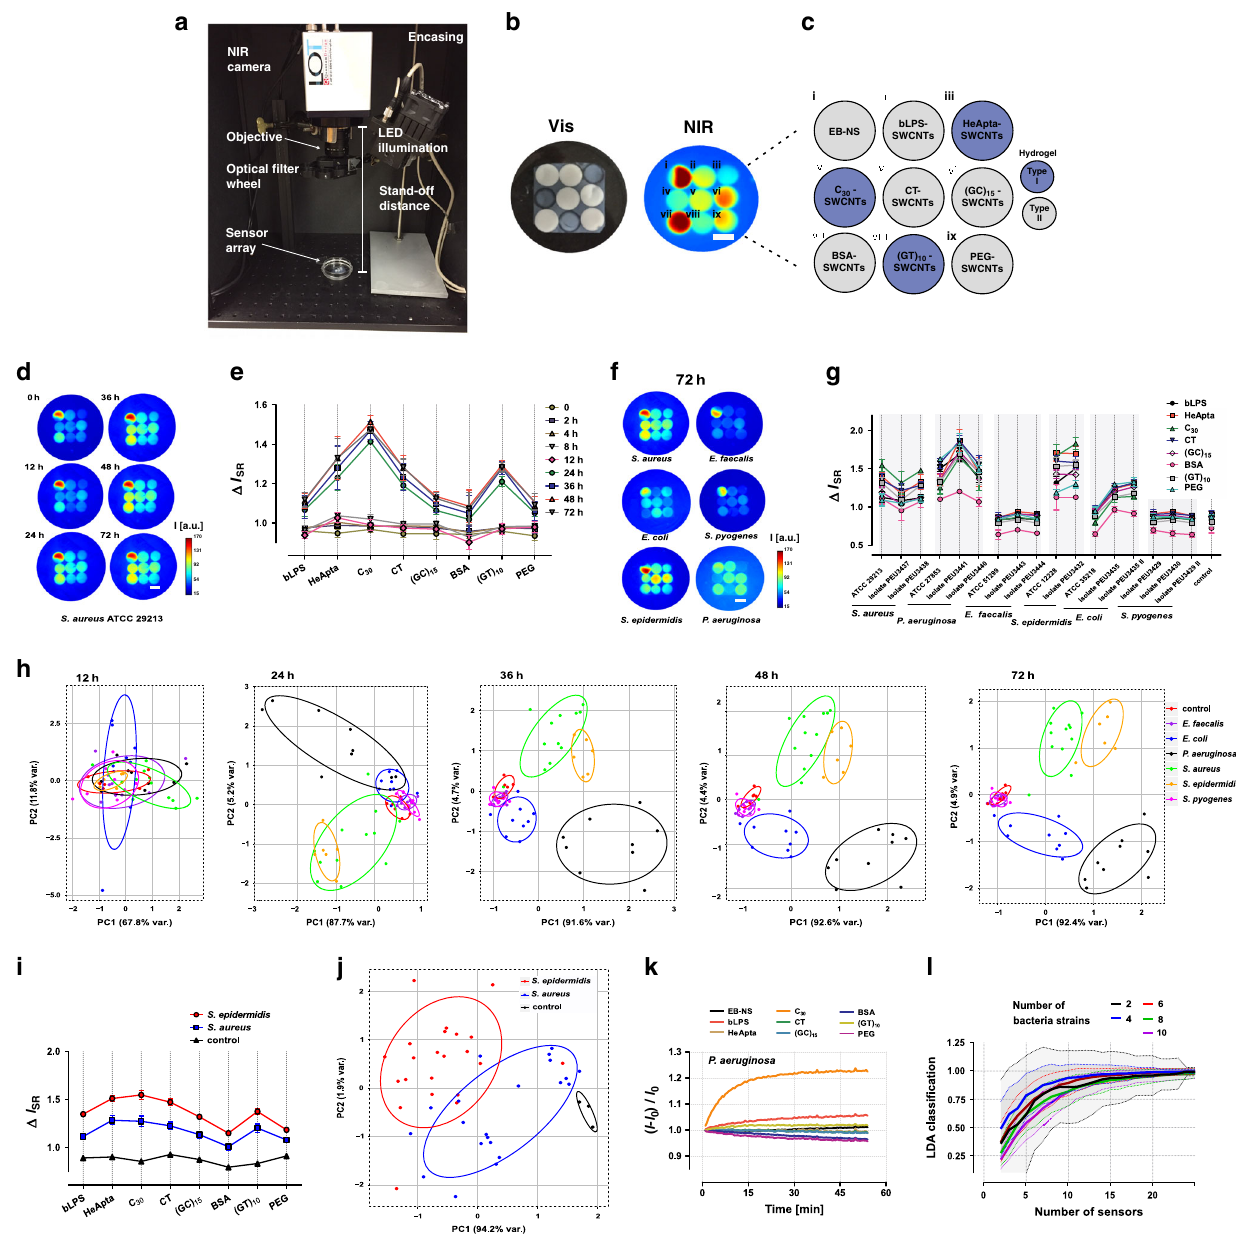
Fig. 4 Remote NIR identi fi cation of bacteria. a A simple NIR stand-off setup enables remote (25 cm) imaging of the NIR fl uorescent sensors embedded in a hydrogel (HG) array. b Photograph (in the visible spectrum) of the HG nanosensor array and its corresponding NIR fl uorescence image (scale bar 0.5 cm). c Arrangement and functionality of the 9 sensors in the HG array. d Remote NIR fl uorescence image of a sensor array incorporated in a microbiological agar plate, inoculated with S. aureus . During bacterial growth the sensor pattern changes (scale bar 0.5 cm). e Corresponding sensor response normalized to the EB-NS signal during S. aureus growth, from 0 to 72 h (n = 3 independent experiments, mean ± SD). f Representative fl uorescence response fi ngerprint of six pathogens, monitored after 72 h. g Fluorescence SWCNT array fi ngerprint of all bacteria and strains, evaluated after 72 h. ( Δ I SR — sensor response: I S1 / I R1 / I S0 / I R0 ; I S — intensity sensor, I R — intensity reference (EB-NS)) ( n = 3 independent experiments, mean ± SD). h PCA (principal component analysis) of the fl uorescence fi ngerprint of all analyzed strains, plotted for different timepoints (12 – 72 h). Each point represents one bacterial sample including clinical isolates from different patients. Control = medium only. i Mean sensor array fi ngerprint from diverse clinical isolates of each S. aureus ( n = 21 biologically independent samples) and S. epidermidis ( n = 22 biologically independent samples) 72 h after incubation. (error = SE). j Corresponding PCA for the array fi ngerprint after 72 h growth of the clinical isolates of S. aureus and S. epidermidis . k Time resolved fl uorescence change of the nanosensor array after addition of liquid culture supernatant from P. aeruginosa . (24 h incubation in LB-medium, I — intensity sensor at t = x; I 0 — intensity sensor at t = 0) (mean of n = 3 independent experiments). l Stochastic simulation that predicts how bacteria discrimination improves with number of sensors. The simulation is based on experimental responses and selectivities as range for novel sensors and uses PCA as well as mean linear discrimination analysis (LDA) to distinguish bacteria. Mean values are plotted and the dashed lines/transparent area represent the SD from 25 independent simulations. Ellipses in ( h , j ) indicate the 0.68 bivariate con fi dence